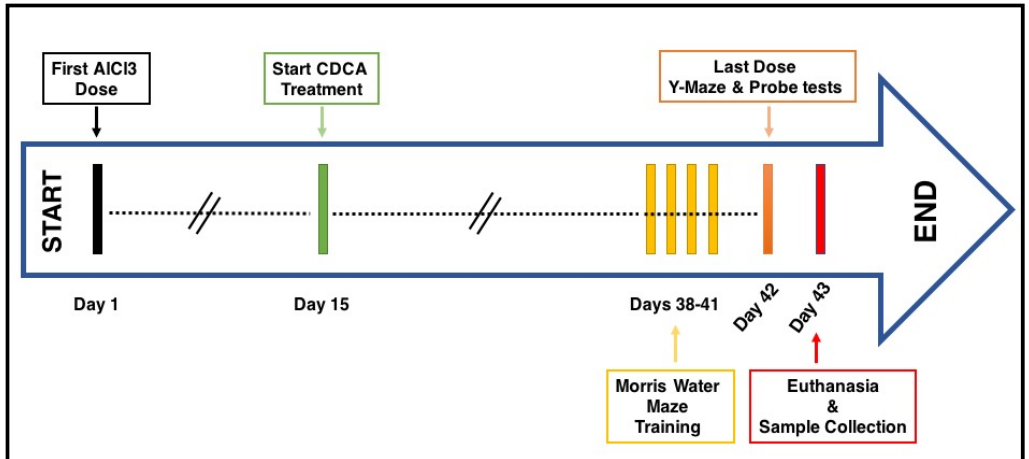
Figure 8. Schematic illustration of the experimental design. Rats were divided into three main groups; control, AlCl 3 and CDCA-treated groups. The experiment lasted for 42 days ( i.e., 6 weeks), in which AlCl 3 treatment started on day 1 in the second and third group, while CDCA administration in the third group started on day 15. On days 38-41, rats were trained in the Morris Water Maze. On day 42, rats received the last treatment and the Y-maze and probe tests were performed. On day 43, rats were euthanized and samples were collected for further biochemical analysis and histopathological examination. AlCl 3 : aluminum chloride; CDCA: chenodeoxycholic acid.